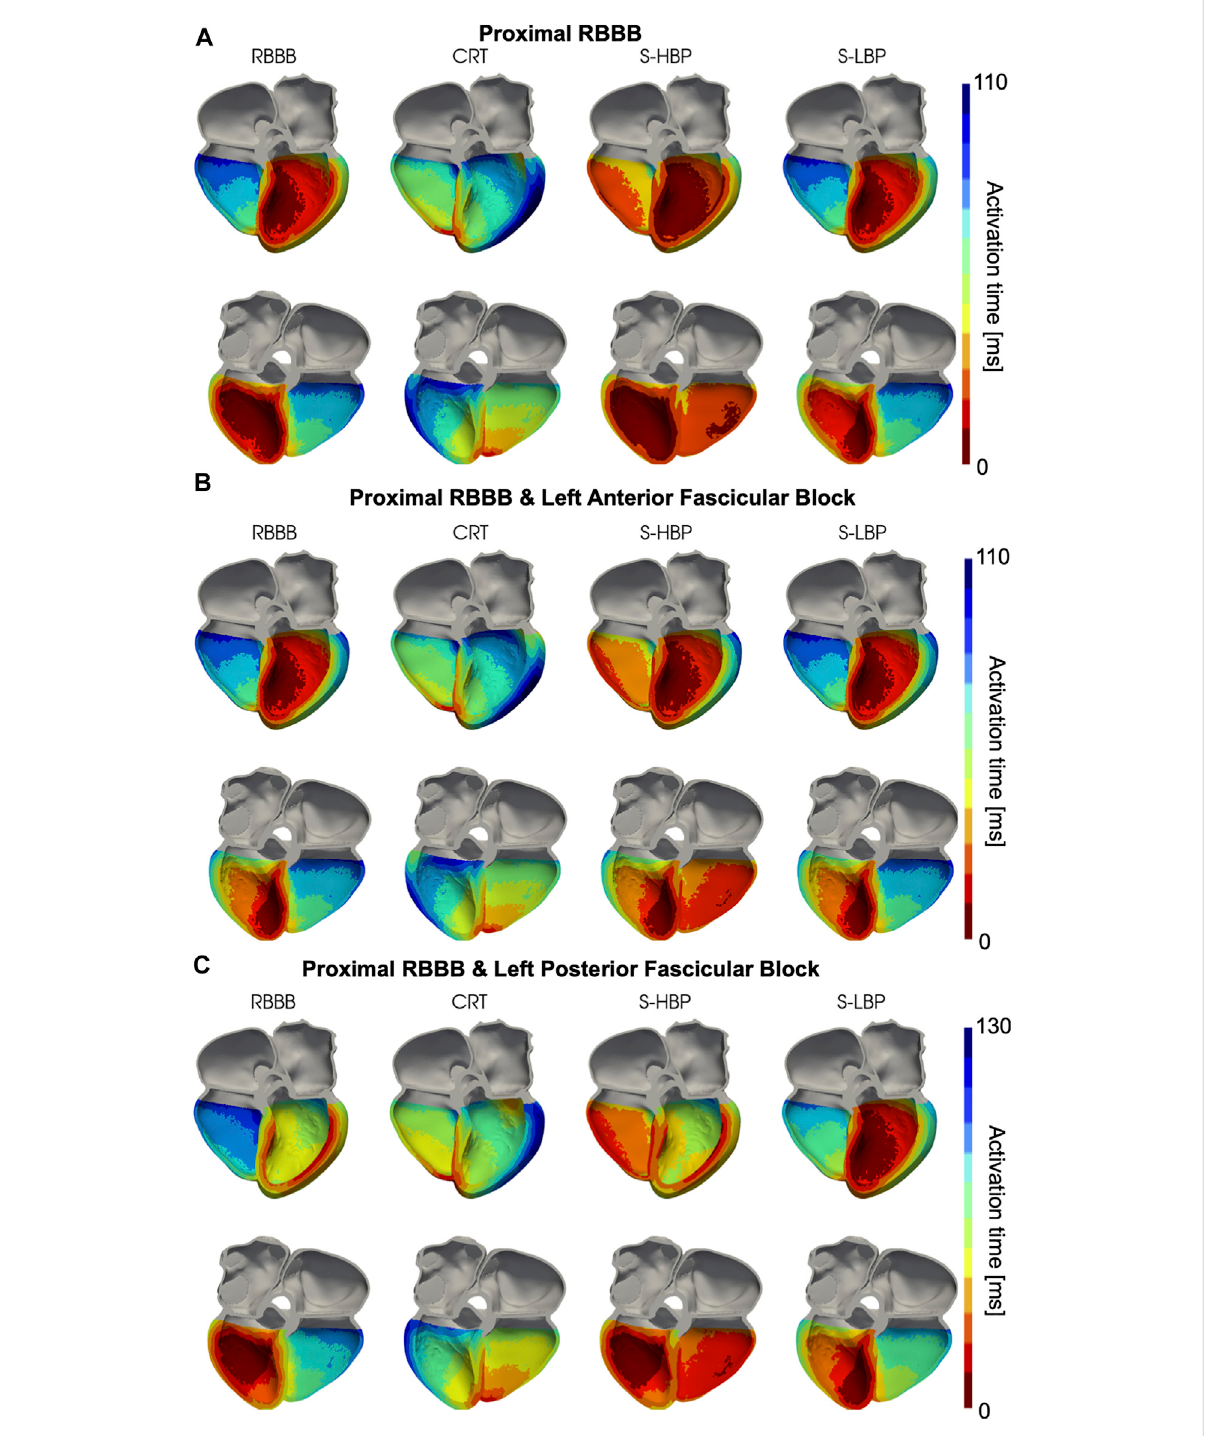
FIGURE 4 Simulated Activation Times (clipped view): Activation times simulated on one of the patients for baseline, CRT, selective HBP (S-HBP) and selective LBP (S-LBP) in the presence of proximal RBBB, shown on an anterior and a posterior clipped view of the mesh to show activation times. Proximal RBBBwas combined with: (A) otherwise normal His-Purkinje system, (B) left anterior fascicular block and (C) leftposterior fascicular